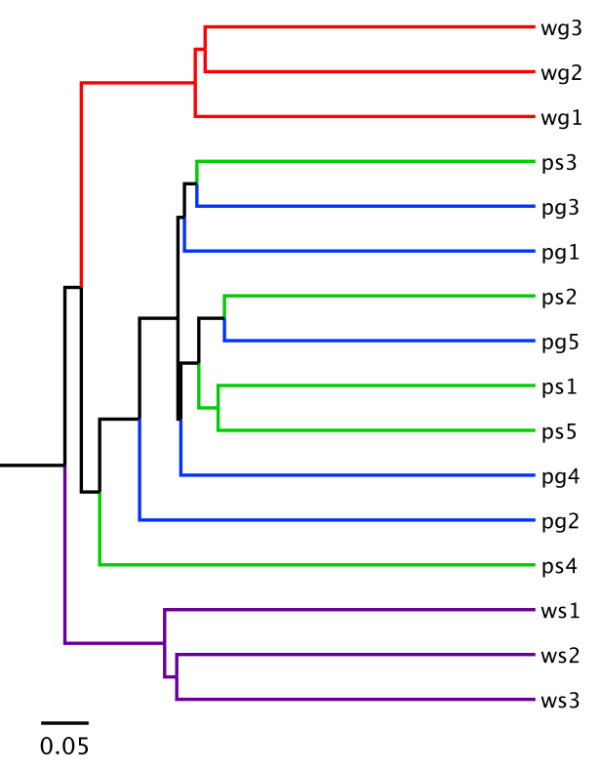
Hierarchical clustering of samples using the Jaccard index. Using shared OTU profiles across all samples, we computed Jaccard indices for clustering samples based on overall community similarity. Samples from each water environment cluster well, but even using OTU resolution, the fruit surface samples were not easily distinguishable.